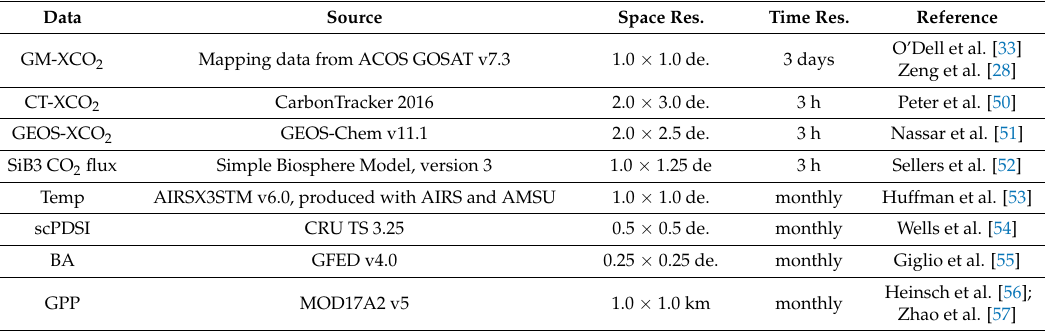
Table 1. Summary of the datasets used in this study. XCO 2 from global mapping of satellite observations (GM-XCO 2 ) and model simulation (CarbonTracker: CT-XCO 2 and GEOS-Chem (described in Section 2.2): GEOS-XCO 2 ), biospheric CO 2 fluxes from SiB3 used in GEOS-Chem,